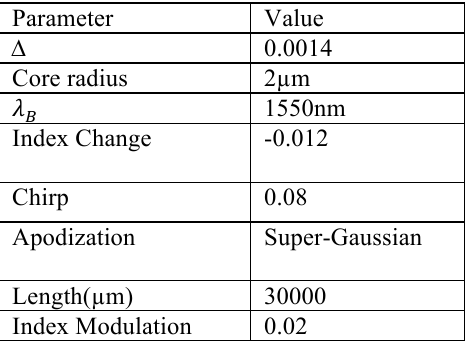
Table 1: Optimised value for FBG structure parameters.